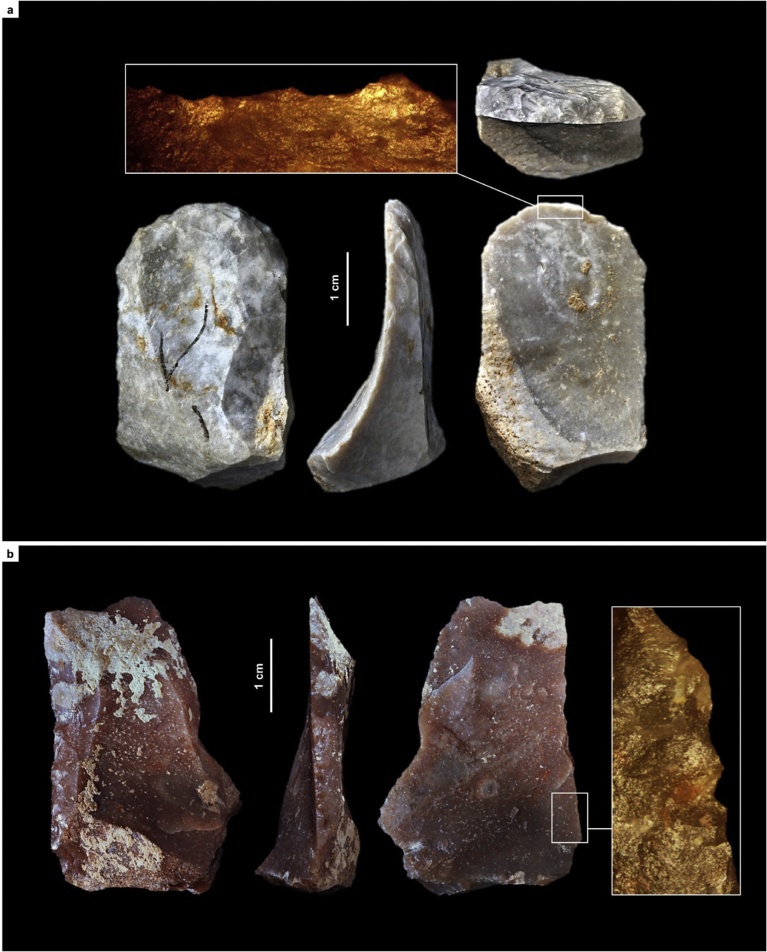
Hide-working tools across the Middle-to-Upper Paleolithic transition at Finca Doña Martina. a. Endscraper from Aurignacian layer 8. b. Sidescraper from Mousterian layer 9. The insets show characteristic microscopic polish (for additional detail, see the SI appendix).